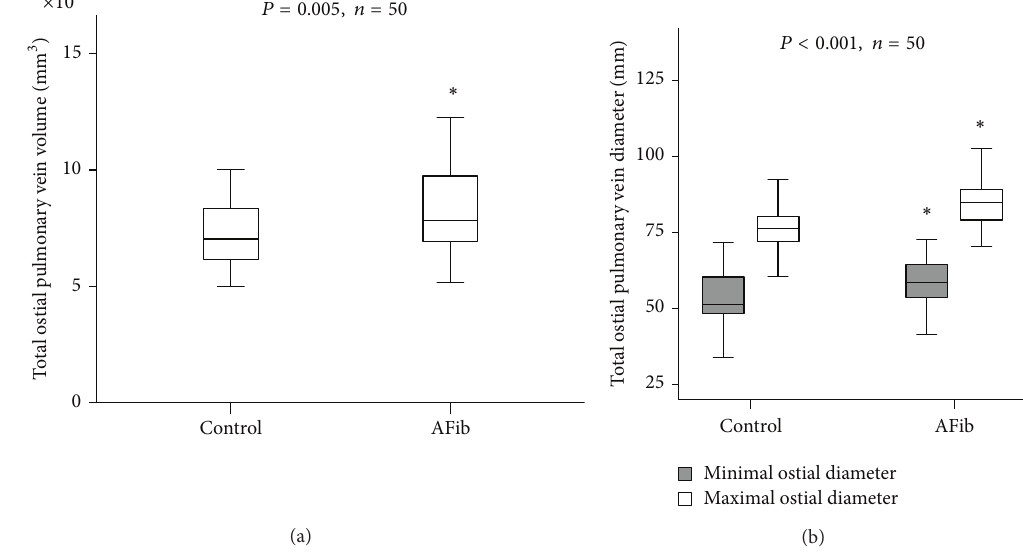
Figure 1: (a) Boxplots of total pulmonary vein (PV) volume (mm 3 ) in patients with atrial fibrillation (AFib) compared to controls with sinus rhythm (SR). (b) Total ostial pulmonary vein (PV) diameter (mm) in patients with atrial fibrillation (AFib) compared to healthy controls with sinus rhythm (SR). Data are presented as mean ± SD; ∗ 𝑃 < 0.05